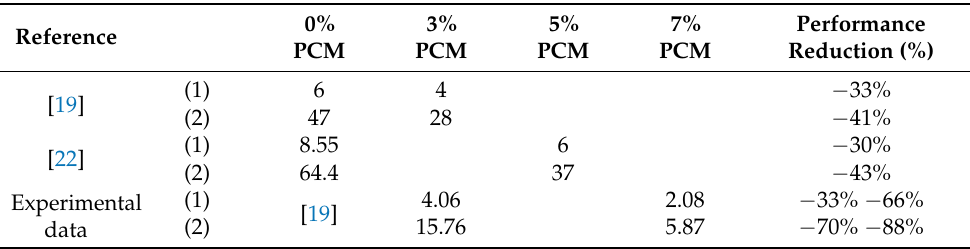
Table 5. Comparative table between data in the literature and data obtained with experimentation, with medium indirect tensile strength (1) and medium compressive strength